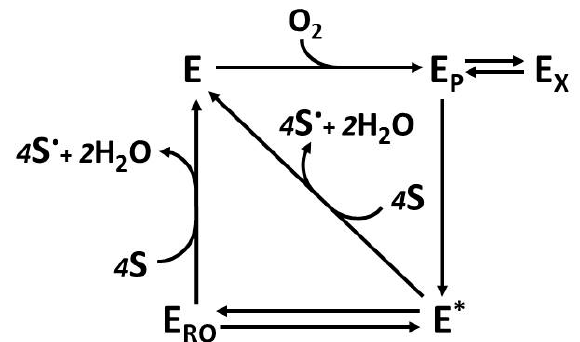
Figure A1. The catalytic cycle of laccase in which enzyme in the native state, E, is oxidized by aqueous oxygen, O 2 , to produce activated enzyme, E*, which reacts with substrate, S, to produce phenoxy radicals, S · . Catalytically slow (E RO ) or non-productive (E P , E X ) states of laccase involved in side reactions are also shown (Source: [5]).